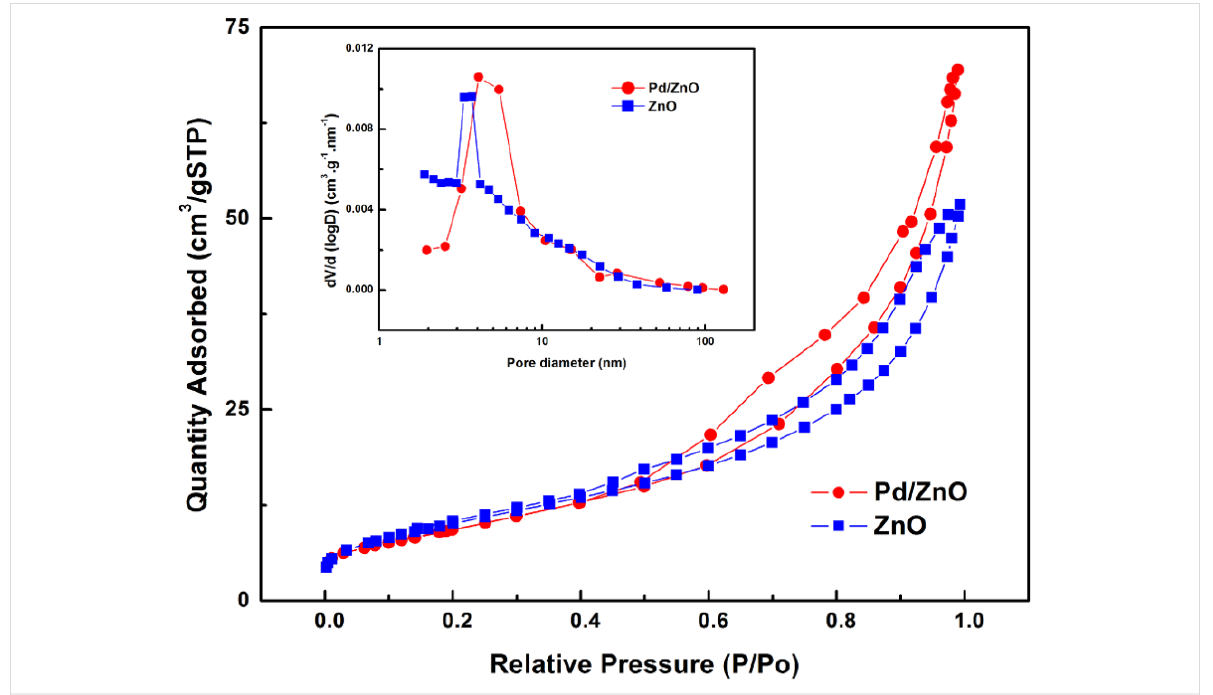
Figure 2: Typical nitrogen adsorption–desorption isotherm and BJH pore size distribution plots (inset) of ZnO and Pd/ZnO nanoparticles.